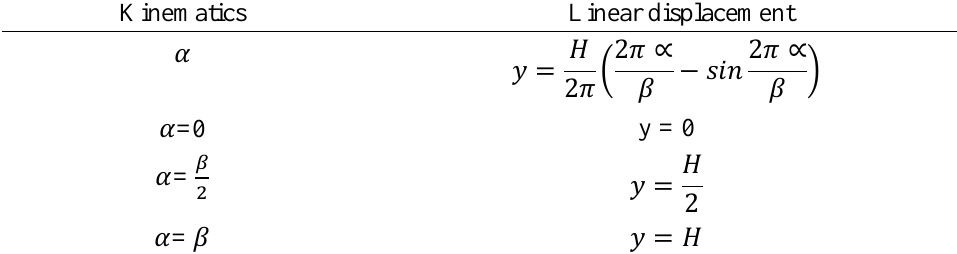
Table 1 . Summary of the kinematic motion of the follower during the rise